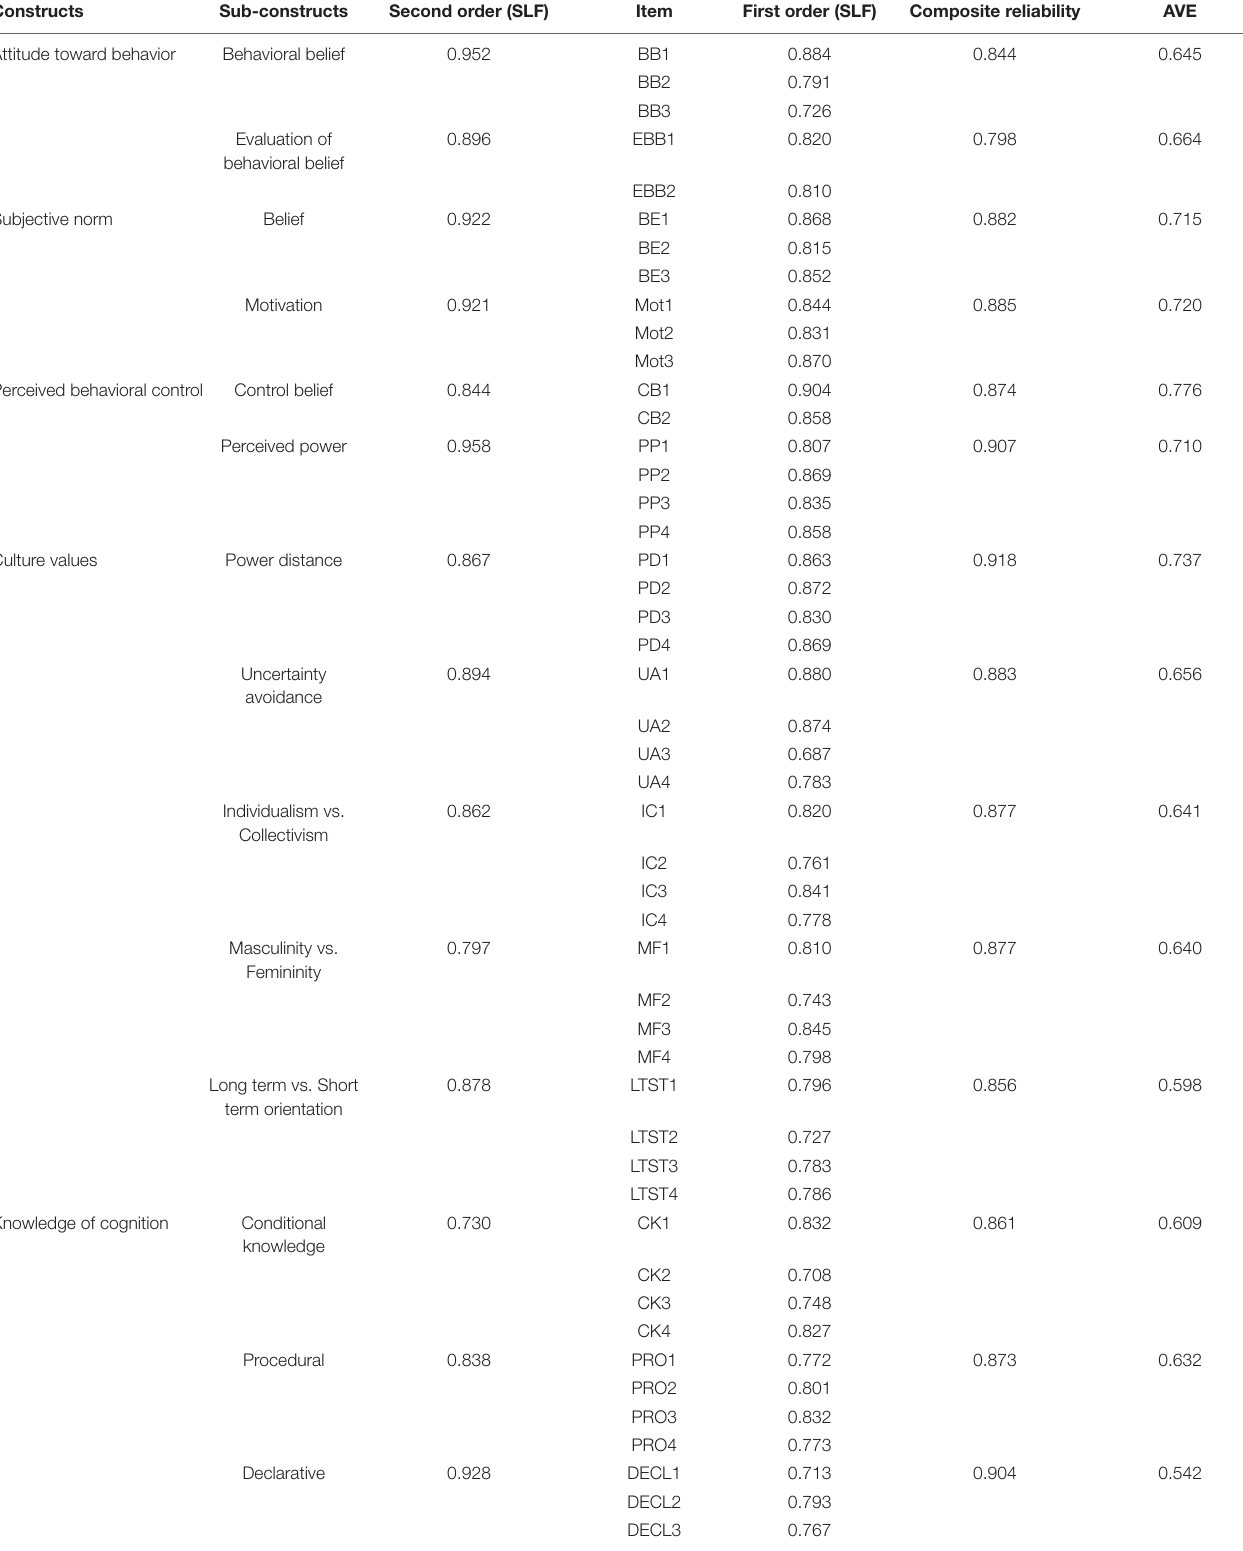
TABLE 3 | Convergent validity, average variance extracted (AVE), and composite